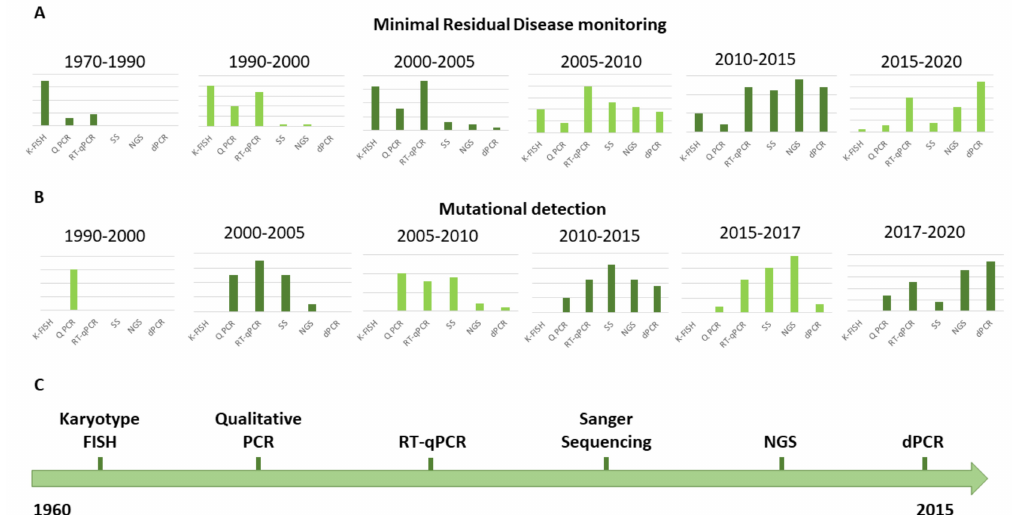
Figure 4. Evolution of the technologies for MRD and mutational status evaluation in CML patients. ( A ) The graphs report the number of publications referring to the application of di ff erent technologies for MRD monitoring in CML patients over the past 60 years. ( B ) The graphs report the number of publications referring to the application of di ff erent technologies for mutation detection in CML patients over the past 30 years. ( C ) The timeline reports the sequential introduction of di ff erent techniques for the MRD monitoring and the detection of mutations in CML patient management. Abbreviations: FISH: fluorescent in situ hybridization; K-FISH: karyotype analysis by chromosome banding and